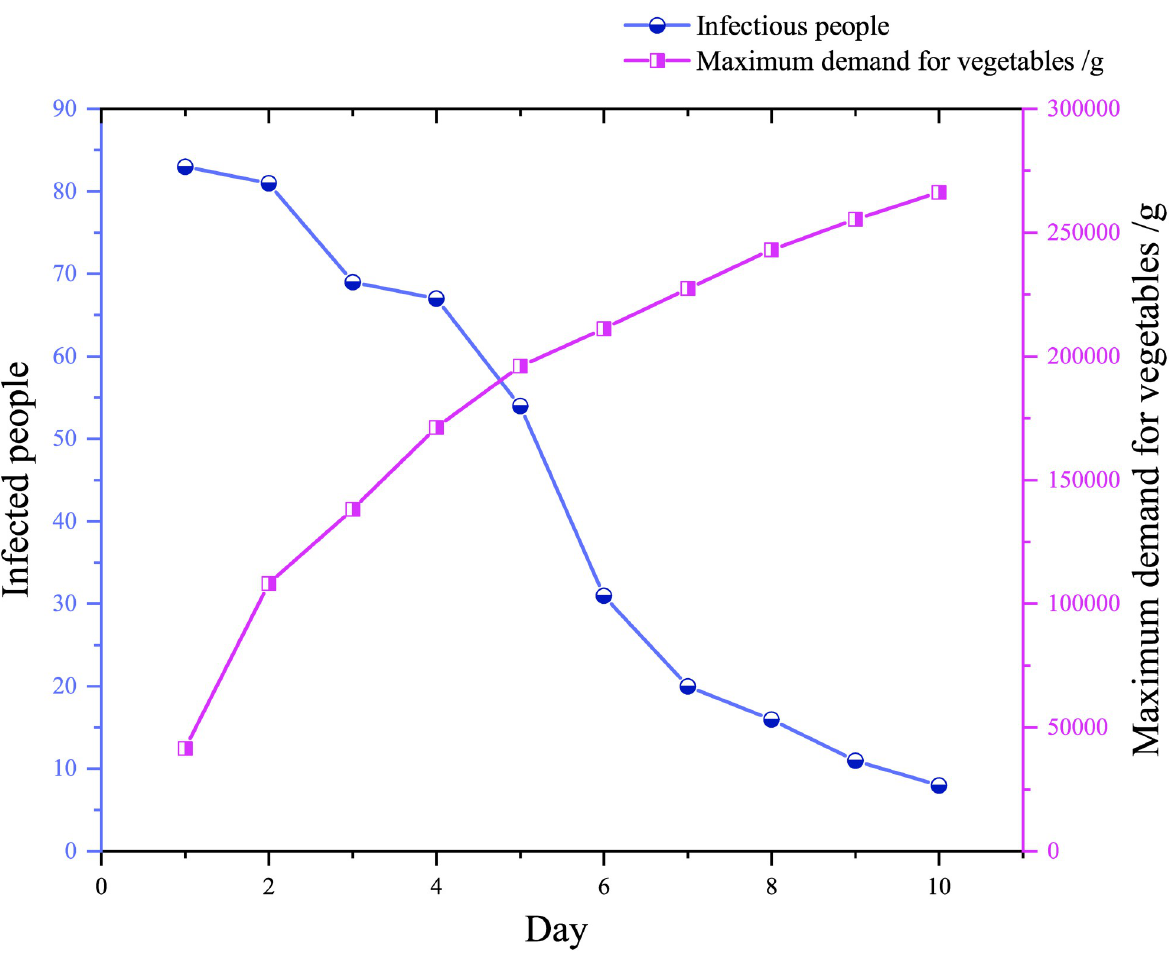
Fig 4. Prediction of emergency supplies.